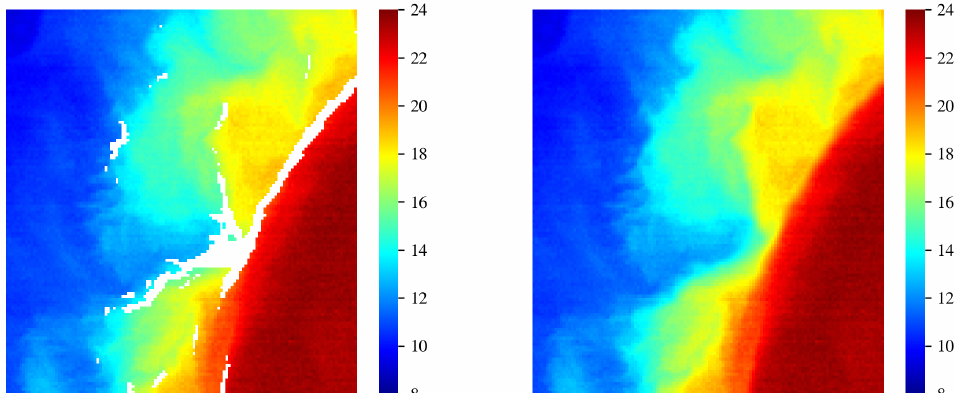
Figure 2. ( left ) Cutout which shows masking (white pixels) due primarily to sharp temperature gradients in this case, which tend to be flagged as low quality by the standard MODIS processing algorithm. ( right ) Same image but with masked pixels replaced by estimated values using the Navier-Stokes in-painting